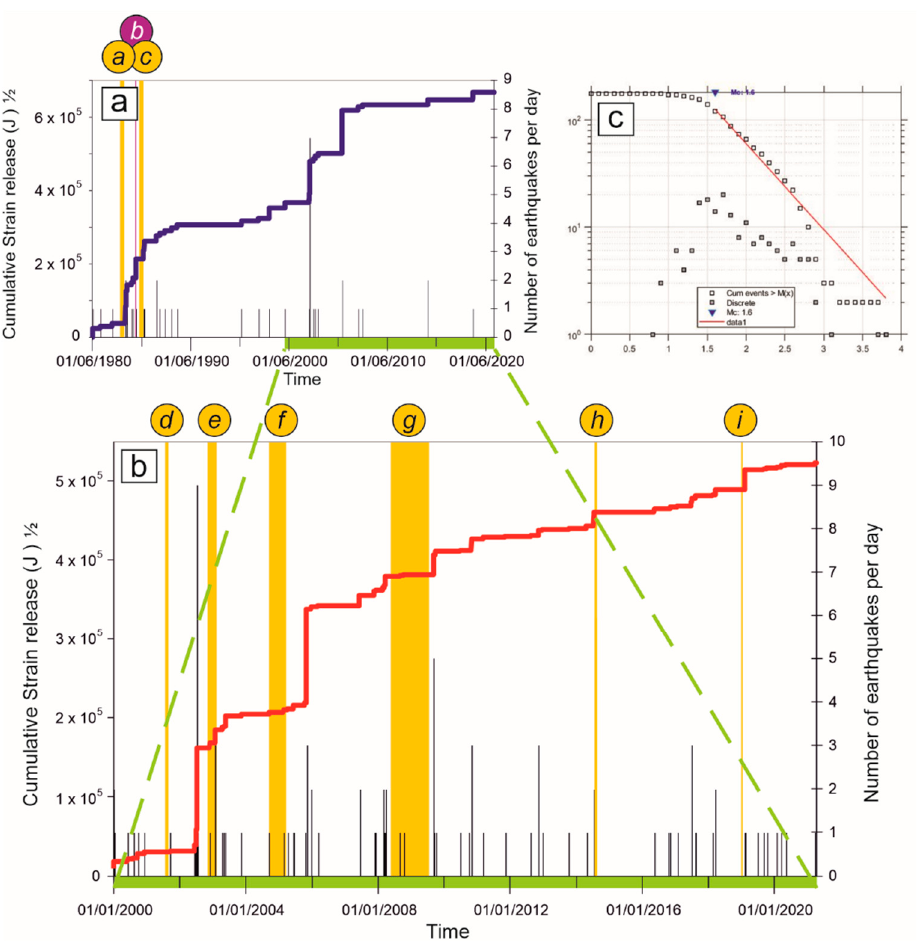
Figure 6. Daily earthquake occurrence and related cumulated strain release for ( a ) C2.5 catalogue and ( b ) CALL catalogue. The periods marked in yellow indicate the main flank eruptions. a: 1983 eruption; b: 1984 Fleri swarm; c: 1985 eruption; d: 2001 eruption; e: 2002–2003 eruption; f: 2004–2005 eruption; g: 2008–2009 eruption; h: South East Crater 2014 activity; i: February 2019 seismicity. ( c ) Magnitude–frequency distribution of earthquakes during the period 2000–2021 for CALL catalogue. Solid triangles represent the number of earthquakes for magnitude class; empty squares indicate the cumulative number of earthquakes greater than or equal to the relative magnitude class. The dashed black line represents the Gutenberg–Richter (G–R) relationship. Mc is the magnitude of com ‐ pleteness.